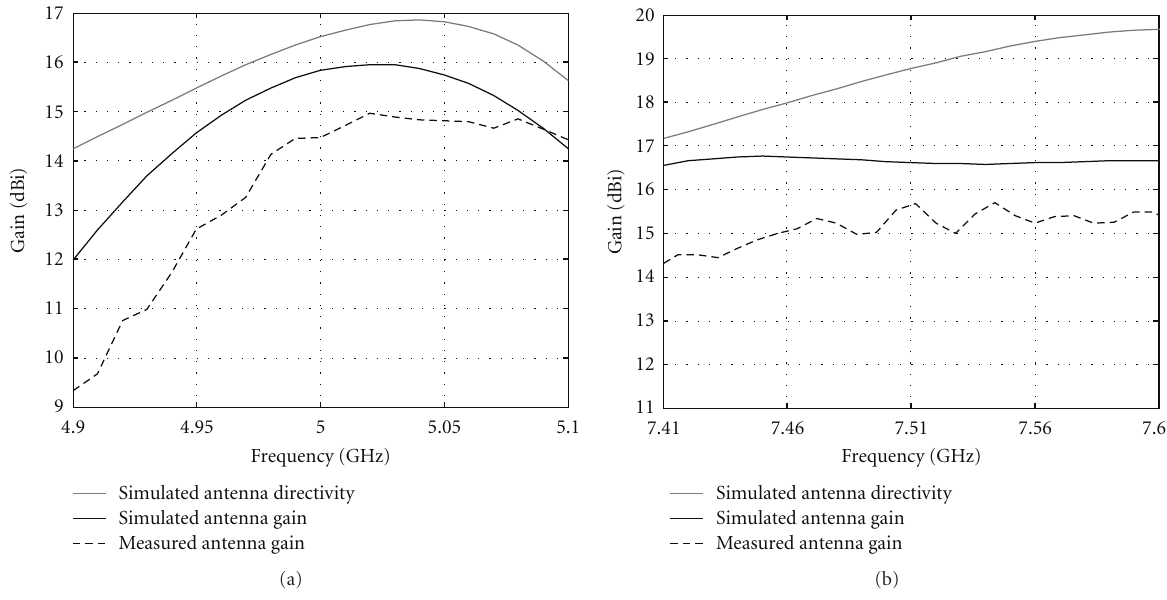
Figure 5: Simulated and measured gain versus frequency at f L (a) and f H